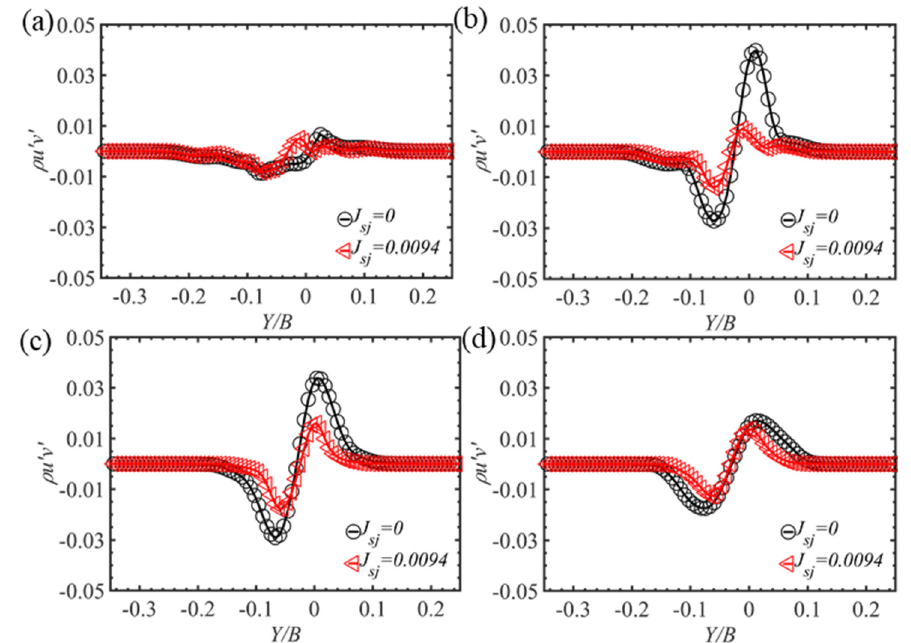
Figure 12. Reynolds stress distributions at different positions behind test model. ( a ) X/B = 0.03, ( b ) X/B = 0.12, ( c ) X/B = 0.21, and ( d ) X/B = 0.30.